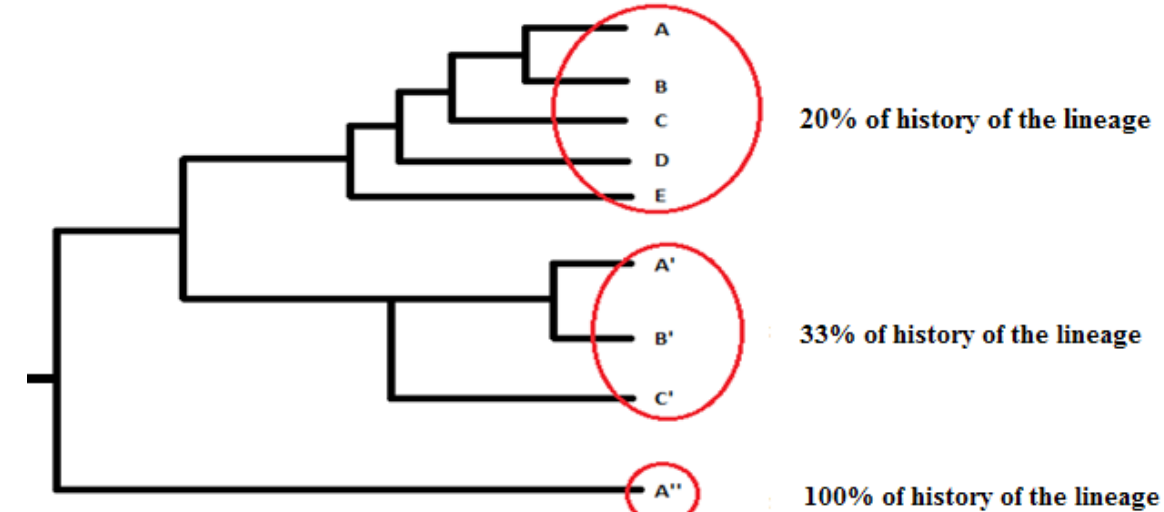
Figure 1: A schematic phylogenetic tree illustrating the unequal representation of evolutionary history captured by each of the nine distal nodes (A to A’’) after (Nee & May,